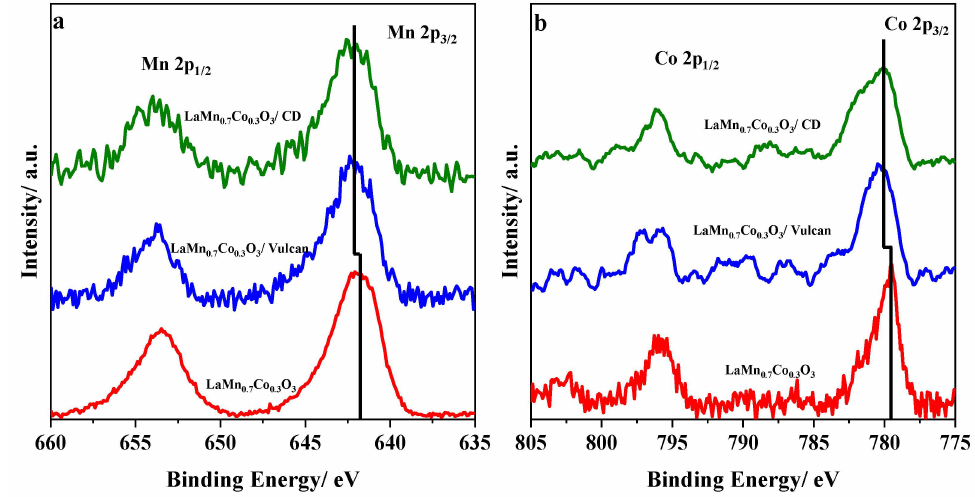
Figure 10. X-ray photoelectron signals obtained from ( a ) Mn 2p and ( b ) Co 2p spectral regions for LaMn 0.7 Co 0.3 O 3 and LaMn 0.7 Co 0.3 O 3 / carbon materials with the same mass